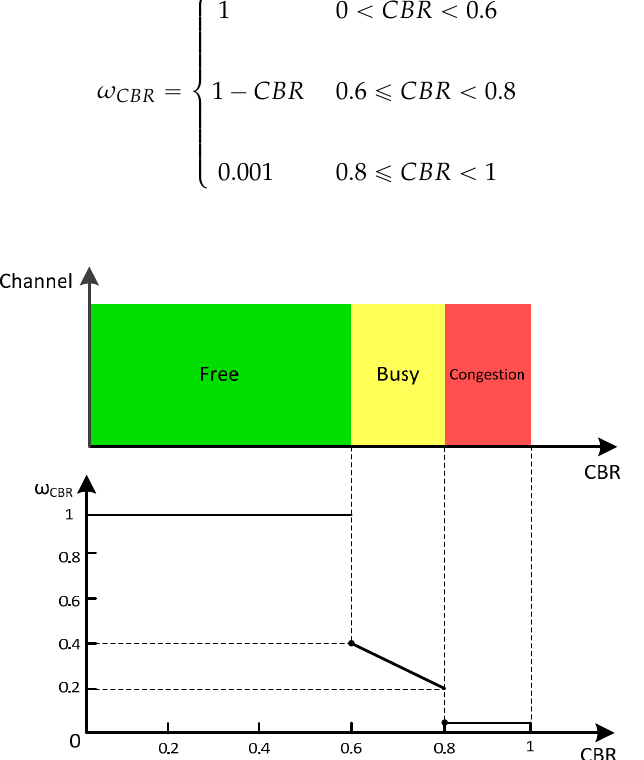
Figure 3. The projection of CBR on the weight ω (cid:2887)(cid:2886)(cid:2902) and channel status.